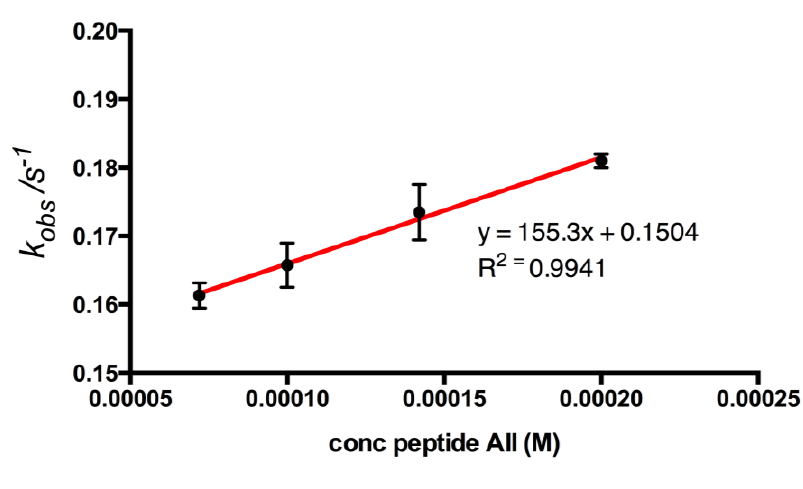
Figure 7. Plot of k constants against corresponding concentrations of peptide AII to obs adenine surface. The k values were calculated using non-linear curve fitting (Origin obs software, OriginLab Corporation, USA), from the association part of QCM binding curves (n = 3). A linear regression curve gives information of association and dissociation rates for peptide AII. Association rate constant ( k ) was calculated to 155 M −1 ·s −1 and dissociation rate a constant ( k ) to 0.150 s −1 for the peptide, corresponding to an apparent K = 968 ± 53.3 d D